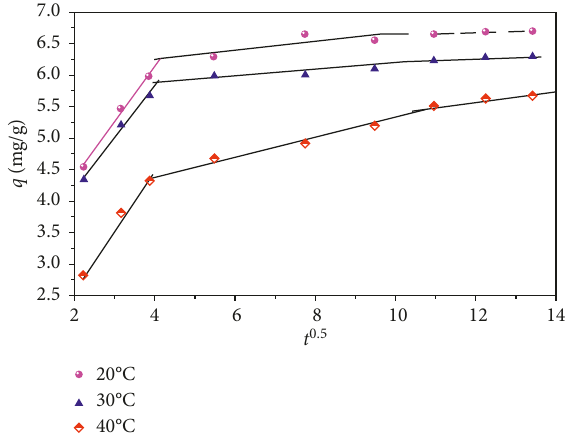
Figure 7: Intraparticle diffusion model for Cr(VI) adsorption onto FSS at 20, 30, and 40 ° C.